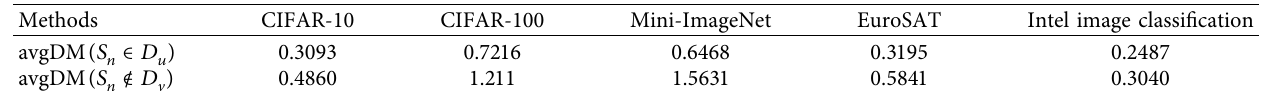
Figure 6: The difference between the output of trained models. The ground truth is label 1 sample of domain 0. (a) The models trained on CIFAR-10. (b) The models trained on CIFAR-100. (c) The models trained on Mini-ImageNet. (d) The models trained on EuroSAT. (e) The models trained on Intel image classification. Table 7: Statistical analysis of model